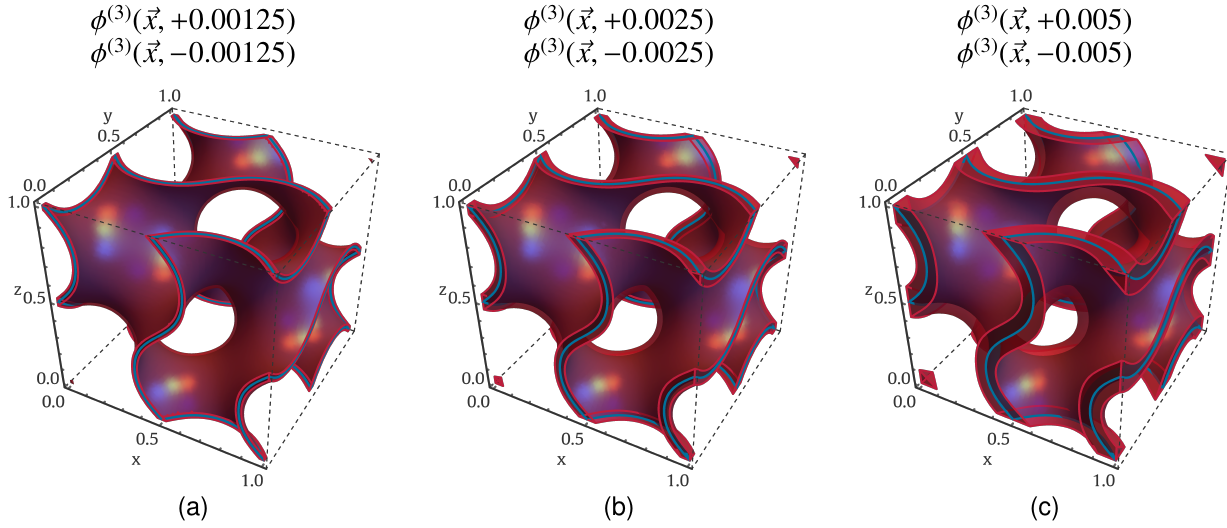
Figure 2. Infill volume enclosed between two offset contours from the original Gyroid interface F G ( (cid:126) x ) = 0. For a unit cell, the offset distance is 0.00125 in ( a ), 0.0025 in ( b ), and 0.005 in ( c ). The third-order offset function was